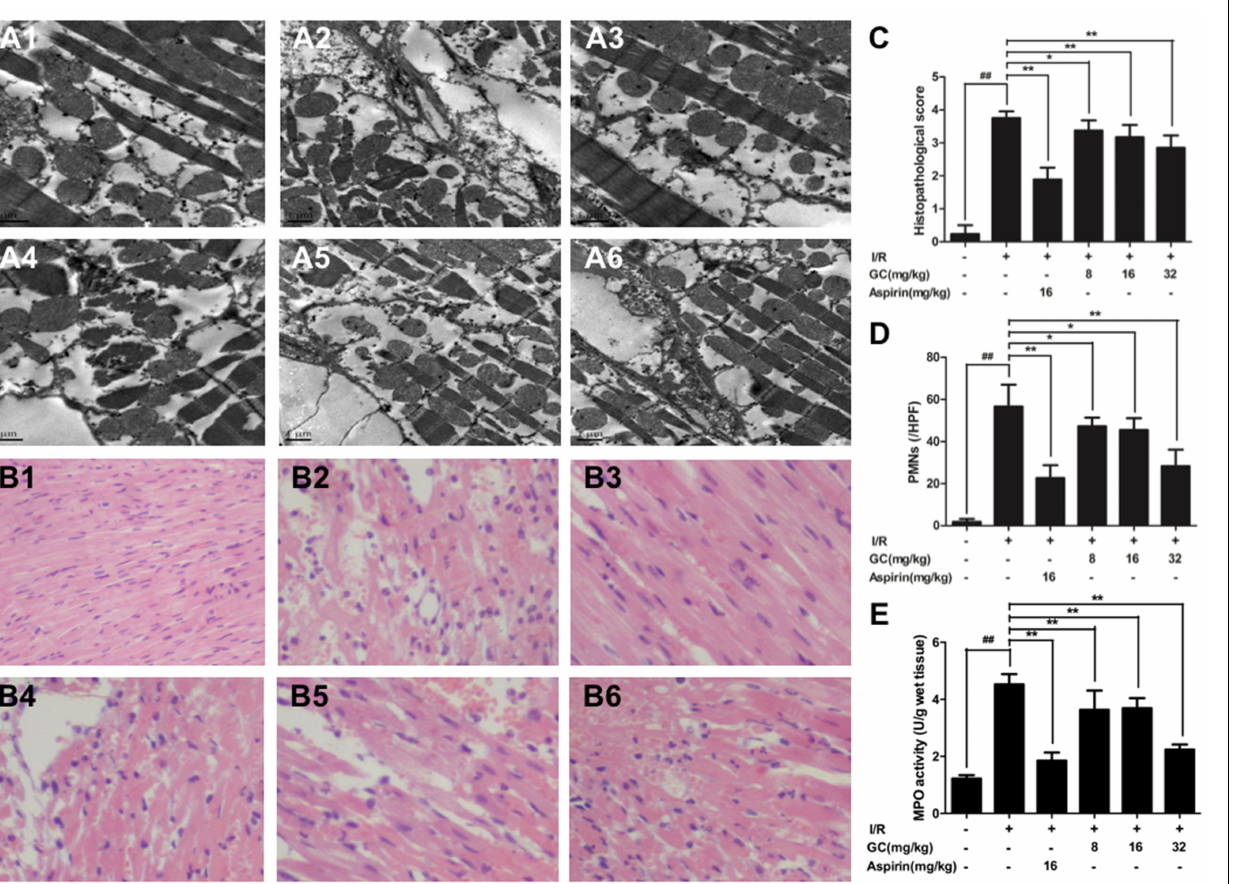
FIGURE 4 | Effects of GC on the ultrastructure of myocardial tissue, histopathological changes, myocardial PMNs counting and MPO activity. (A1–A6) Representative transmission electron microscopy (TEM) observation of myocardial tissue injury for control group (A1) , I/R group (A2) , I/R + 16 mg/kg Aspirin group (A3) , I/R + 8 mg/kg GC group (A4) , I/R + 16 mg/kg GC group (A5) , I/R + 32 mg/kg GC group (A6) . (B1–B6) Representative light microscopic appearance of rat myocardial histopathological morphology (HE staining; original magnification × 200) for control group (B1) , I/R group (B2) , I/R + 16 mg/kg Aspirin group (B3) , I/R + 8 mg/kg GC group (B4) , I/R + 16 mg/kg GC group (B5) , I/R + 32 mg/kg GC group (B6) . (C) Effect of GC on histopathological scores, (D) effect of GC on myocardial PMNs counting and (E) effect of GC on MPO activity. The location of the histological images was taken in the infarcted area. Data were expressed as mean ± SD ( n = 8). ## P < 0.01 vs. control group; ∗ P < 0.05, ∗∗ P < 0.01 vs. I/R group. TABLE 1 | Effects of GC on serum inflammatory cytokines after I/R in rats. Group Dose (mg/kg) TNF- α (pg/mL) IL-1 β (pg/mL) IL-6 (pg/mL) Control